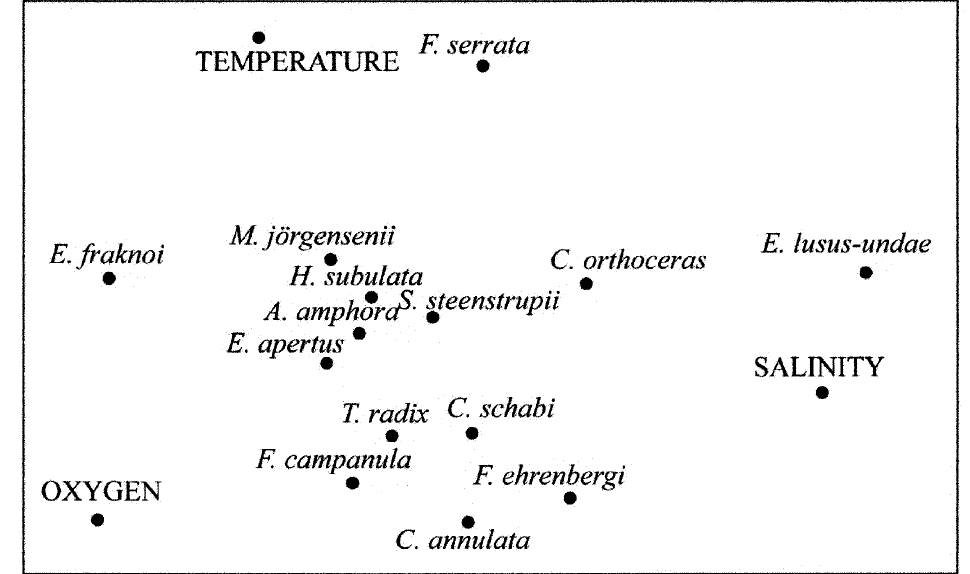
F IG . 4. – Multi-Dimensional Scaling (MDS) plot in two dimensions for the tintinnid community in Büyükçekmece Bay with relation to temperature, salinity and